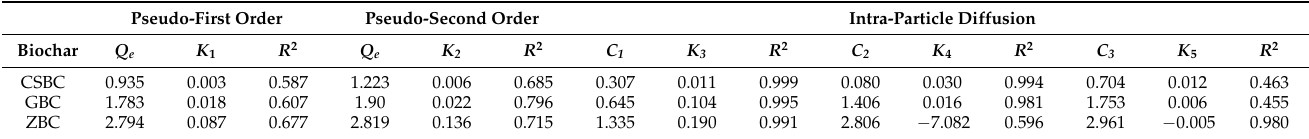
Table 2. Parameters of adsorption kinetics for P removal by GBC, CSBC, and ZBC.